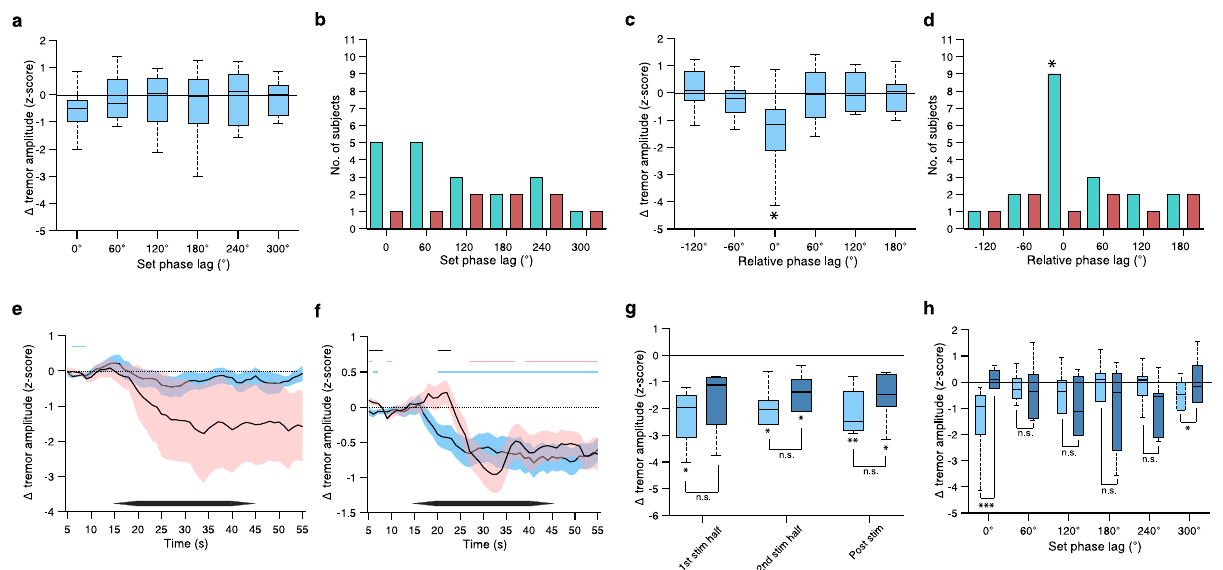
Fig. 4 Characterisation of phasic dependency and reproducibility of induced change in tremor amplitude. a – d Effect of the phase lag of stimulation. Shown values are for 2nd stim half. See Supplementary Table 5 for complete statistical data including 1st stim half and post-stimulation period. a Change in tremor amplitude vs. stimulation phase lag; n = 11 participants. b Number of participants with signi fi cant reduced (turquoise bars) and increased (red bars) tremor amplitude during 2nd stim half vs. stimulation phase lag. c Same as ( a ) but phase lags of each participant are expressed relative to the phase lag showing the largest reduction in tremor amplitude and wrap to ±180°. d Same as ( b ) but phase lags of each participant are expressed as in ( c ). e – h Characterisation of tremor amplitude during a repeated experiment in a subset of participants (participants 1,2,3,6, 9 and 11), see Supplementary Table 6 for statistics. e Change in tremor amplitude over time when stimulating currents were applied at the tremor frequency but without phase-locking, showing original experiment (blue) and repeated experiment (red); horizontal blue and red lines show epochs with signi fi cant z -score amplitude in original and repeated experiments, respectively; horizontal black lines show epochs with a signi fi cant difference in z -score amplitude between original and repeated experiments. f Same as ( e ) but stimulating currents were phase-locked to the tremor movement. g Change in tremor amplitude across the participants with signi fi cant in tremor amplitude in ( f ) in original experiment (light blue) and repeated experiment (dark blue); see Supplementary Table 7 for full statistics. h Change in tremor amplitude vs. stimulation phase lag, colour scheme as in ( g ); see Supplementary Table 8 for full statistics. Box plots throughout show 25 and 75% percentile values; horizontal red line, median value; horizontal black lines, data range. Signi fi cance of z -score amplitude and number of participants was analysed as in Fig. 3. Signi fi cance in ( c ) was also analysed using 2-sample Kolmogorov – Smirnov test. * indicates p < 0.05, ** p < 0.005, *** p < 0.0005, n.s. non-signi fi cant throughout the fi gure. Source data are provided as a Source Data fi